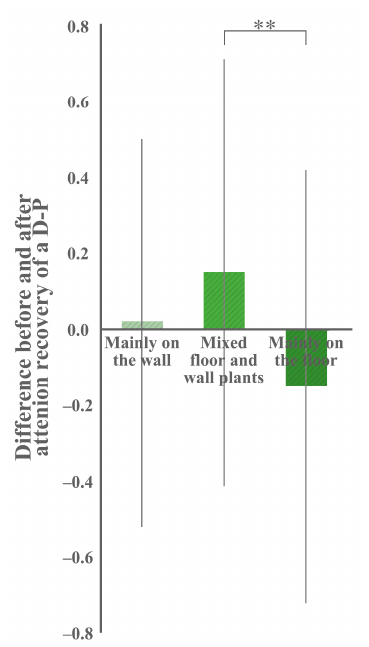
Figure 12. Main effect maps of the leaf size of indoor plants on attention recovery. ** Stands for statistical significance at the 0.01 level; * Stands for statistical significance at the 0.05 level; Not marked stands for no statistical significance.